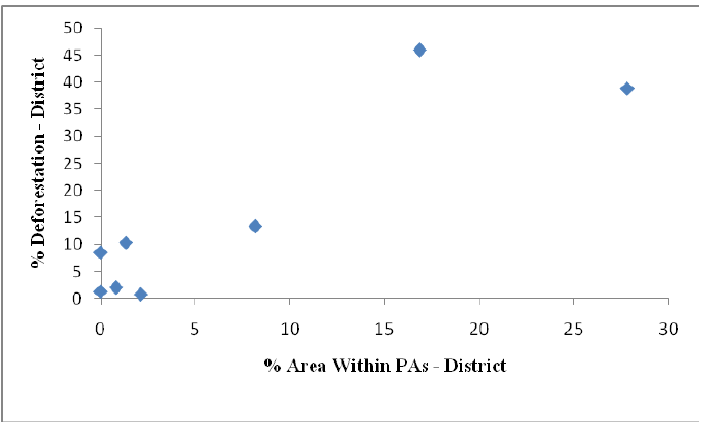
Figure 15a. Relationship between percentage of area within PAs and the distribution of deforestation for districts.